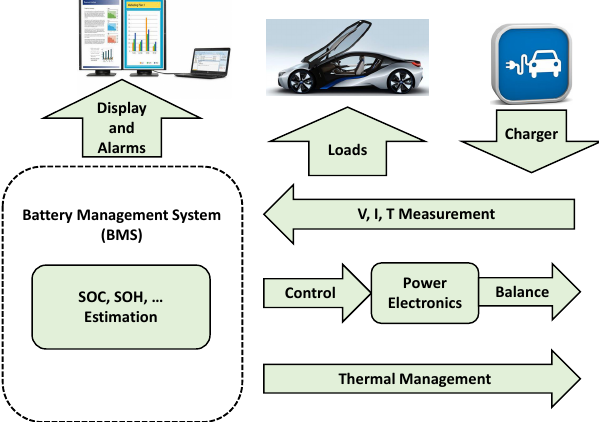
Figure 1. Overall architecture of a battery management system (BMS). SOC: state of charge; and SOH: state of